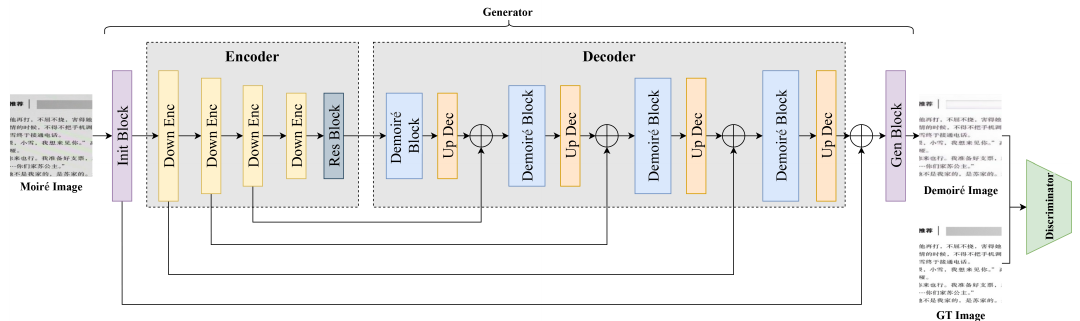
Figure 1. The overall structure of our proposed FSD-Net, which consists of a generator and a discriminator. The generator is designed following the image encode-decode